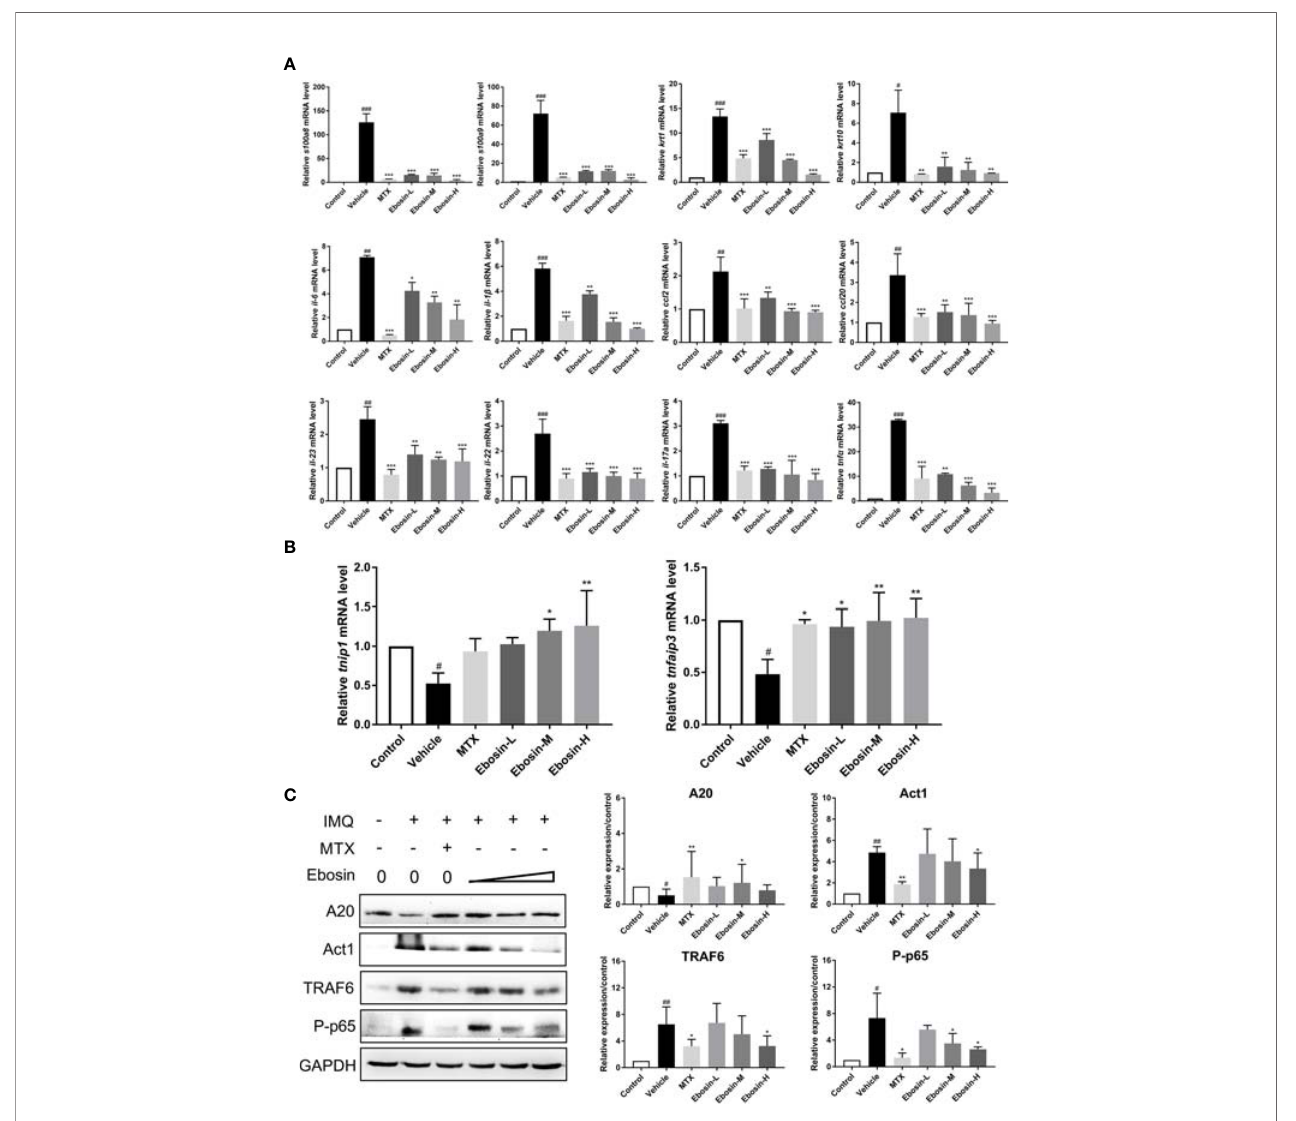
FIGURE 5 | Ebosin inhibited the in fl ammatory response and IL-17 signaling pathway. (A) RT-PCR analyses of cytokines in psoriasis-like mice without or with Methotrexate (MTX) and Ebosin. (B) RT-PCR analyses of tnfaip3 and tnip1 in psoriasis-like mice without or with MTX and Ebosin. (C) Western blotting analyses for proteins on IL-17 signaling pathway in psoriasis-like mice without or with MTX and Ebosin, including A20, Act1, TRAF6, and phosphor-p65. All data were presented as mean ± SD; n = 3. # P < 0.05, ## P < 0.01, ### P < 0.001 vs. control; * P < 0.05, **P < 0.01, ***P < 0.001 vs. IMQ-induced vehicle